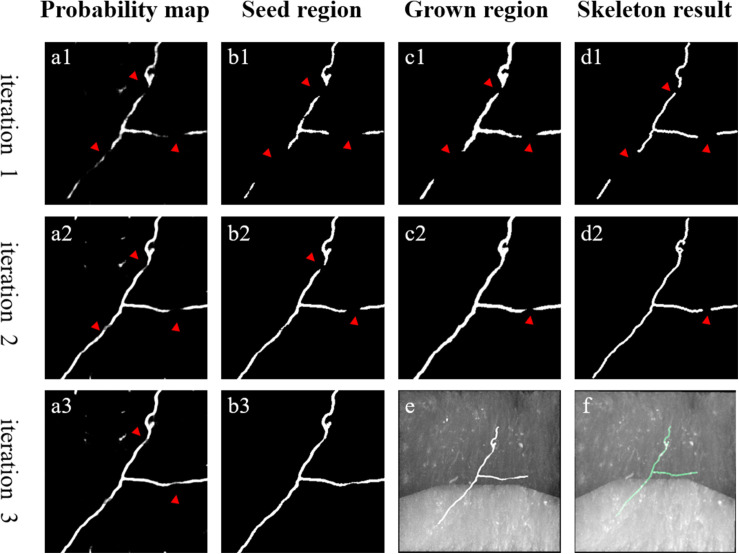
An example of weak neurite mining process for pseudo-label refinement. (a1–a3) Estimated foreground probability map by CNN. (b1–b3) Seed region of foreground via maximum probability classification and image denoising. (c1,c2) Grow the seed region to include nearby weak neurites. (d1,d2) Skeleton of the grown region to refine pseudo labels. (e,f) Overlapped results of predicted neurites by CNN, manual annotation and original images, respectively. Red arrows point to the changed areas.